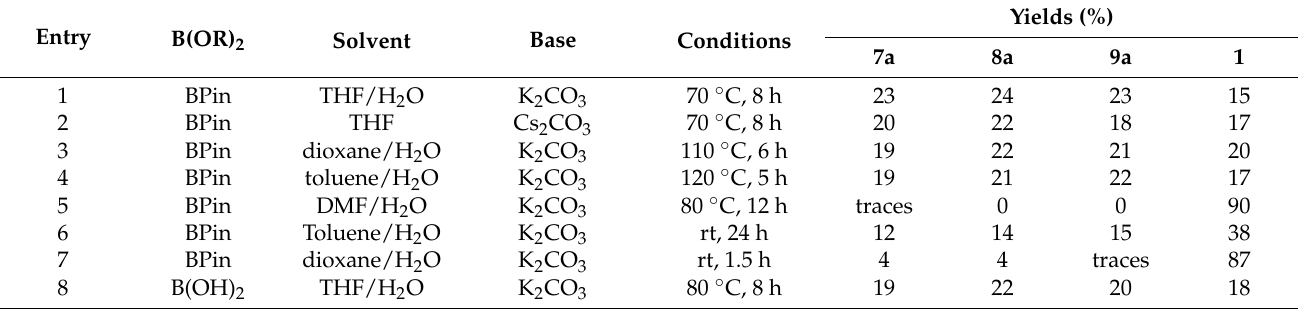
Table 1. Cross-coupling of 4,7-dibromobenzo[ d ][1,2,3]thiadiazole 1 with (9-hexyl-9 H -carbazol-3-